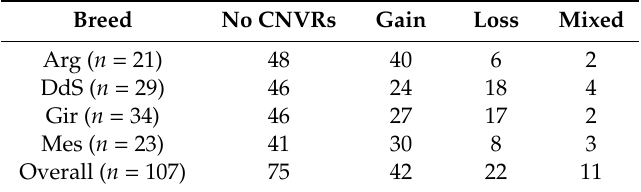
Table 1. CNVR details for each goat breed and overall. Number of animals per breed are reported within brackets. Arg = Argentata; DdS = Derivata di Siria; Gir = Girgentana; Mes = Messinese.